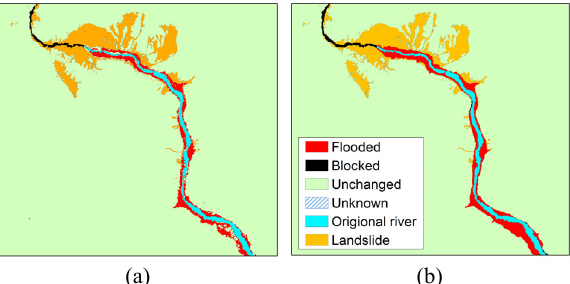
Figure 4. Change detection result of the proposed method and the ground truth. (a) Detection result of the proposed method (The original river (blue) and landslide area (yellow) are added manually based on the ground truth); (b) The ground truth provided by manual interpretation.